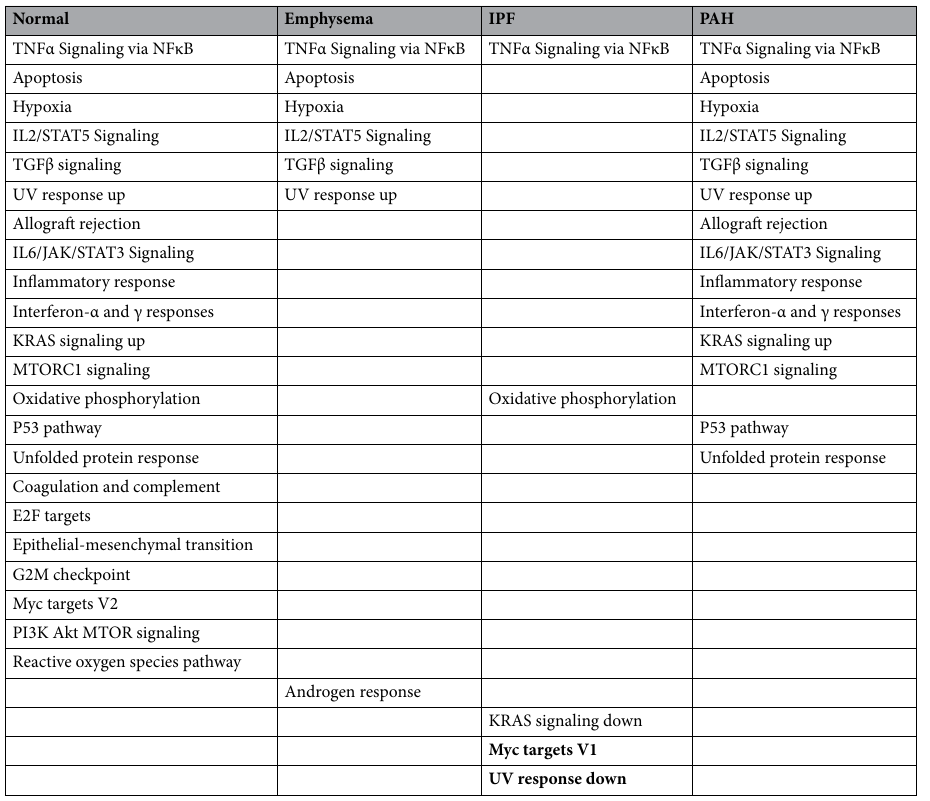
Table 4. Pathways identified to be upregulated or downregulated (bold letters) with EVLP.